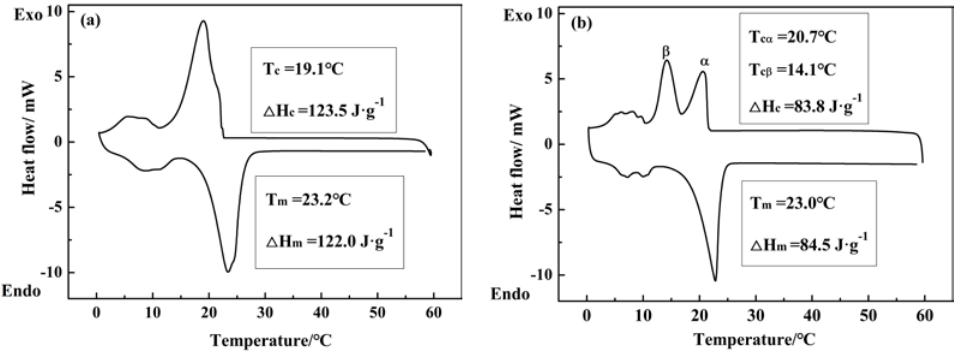
Figure 9. DSC curve of ( a ) butyl stearate and ( b ) MicroPCMs.